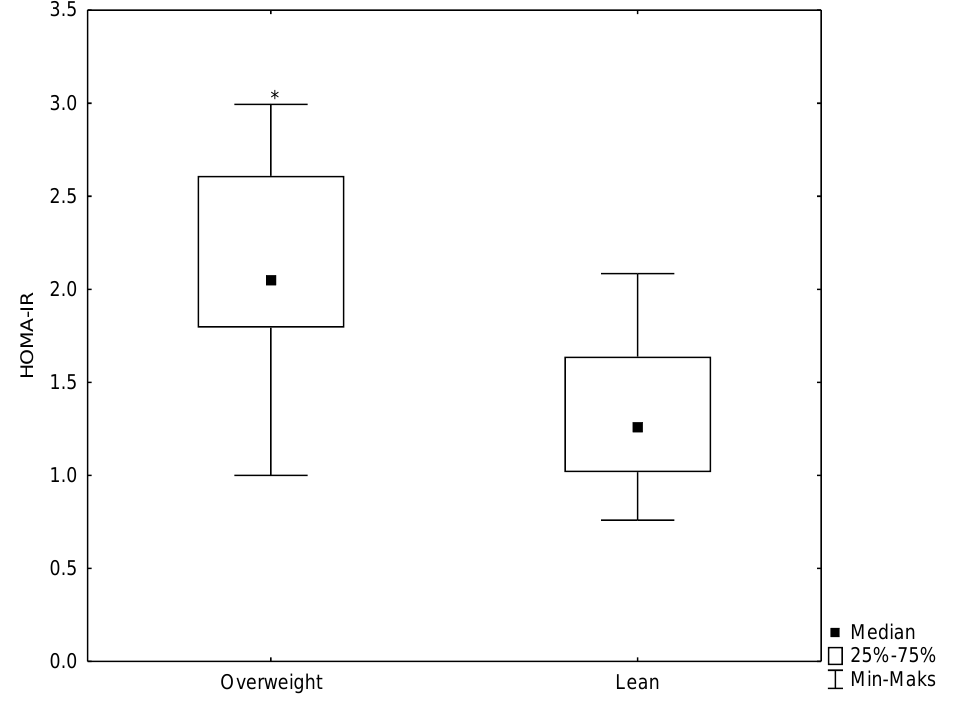
Figure 2. A box-whisker plot for the insulin concentrations in the studied groups. * statistically significant difference at p < 0.05